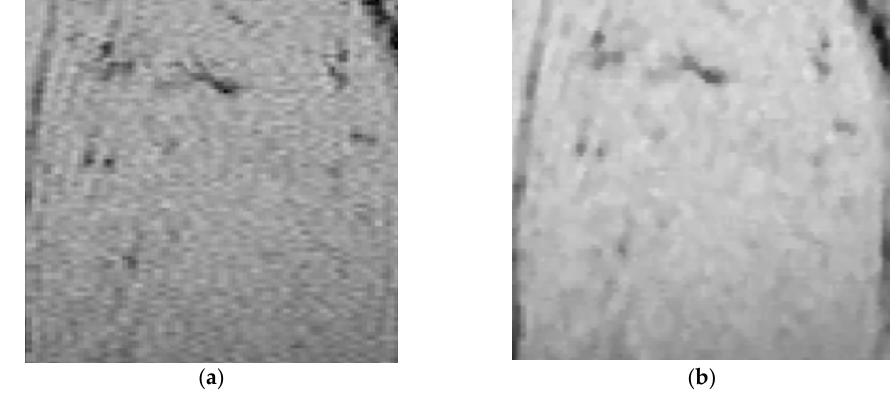
Figure 2. Pre-processing: ( a ) original image, ( b ) pre-processing image.